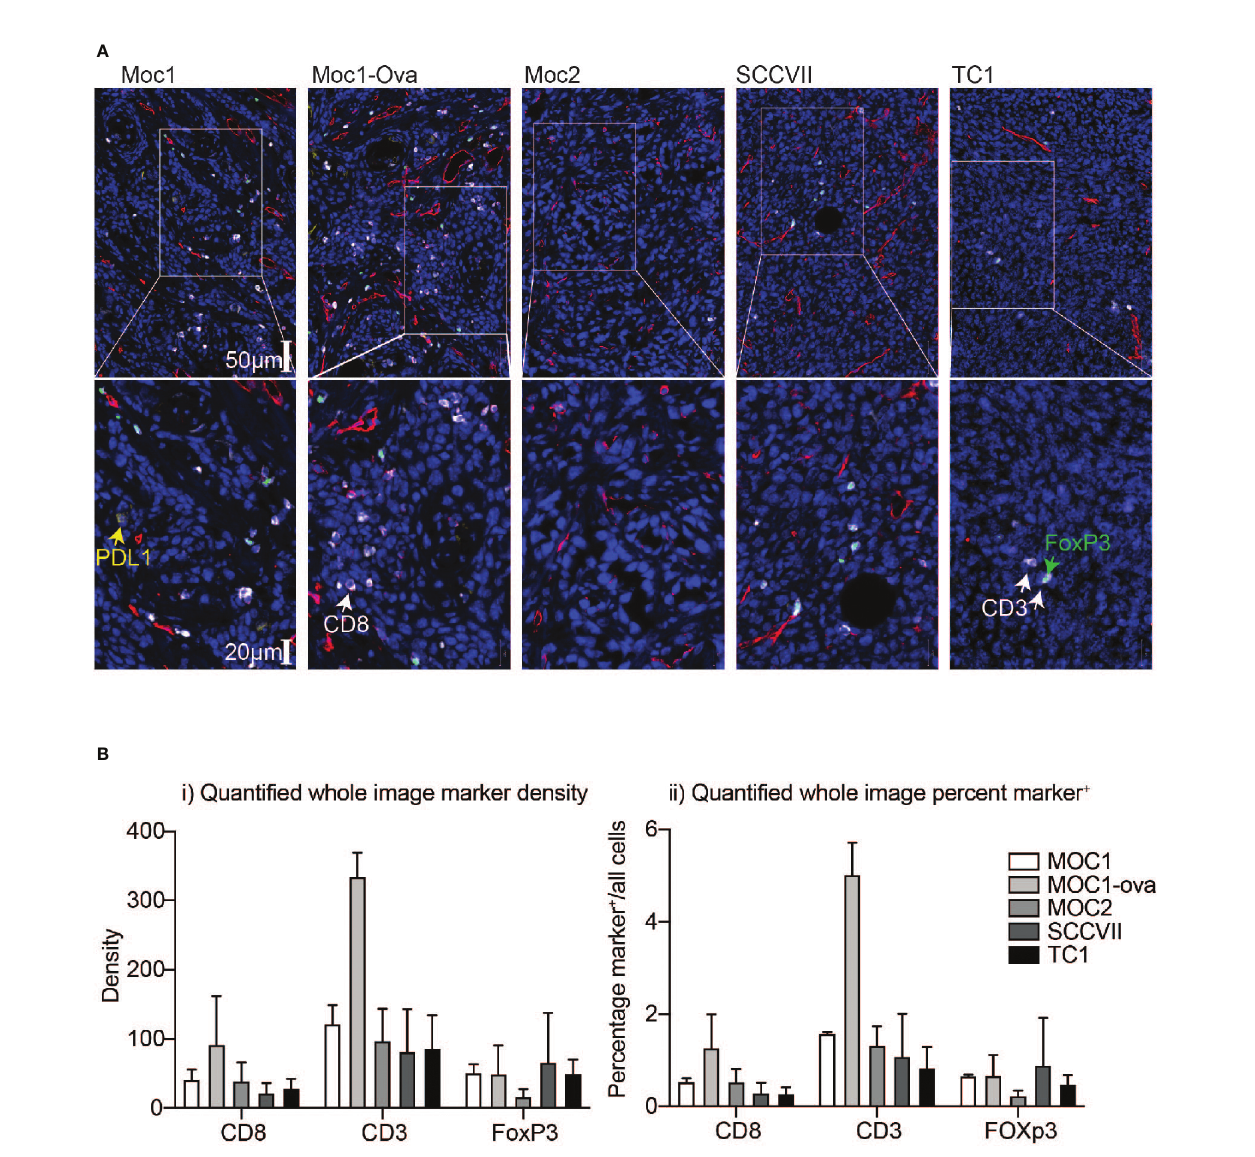
FIGURE 1 | Differential immune in fi ltration across murine HNSCC tumor models by immunohistology. Tumors were established in immune-competent animals and tumors were harvested for analysis of in fi ltrating immune cells by IHC. (A) Representative images following multiplex IHC for in fi ltrating immune cells in the tumor showing PDL1 (yellow), CD3 (white), CD8 (red), FoxP3 (green), DAPI, (blue). Lower images are higher magni fi cation inset of upper images. Scale bars are shown. (B) Quanti fi cation of i) marker density and ii) percent marker positive across tumor models. Graphs show means and SD of two tumors per